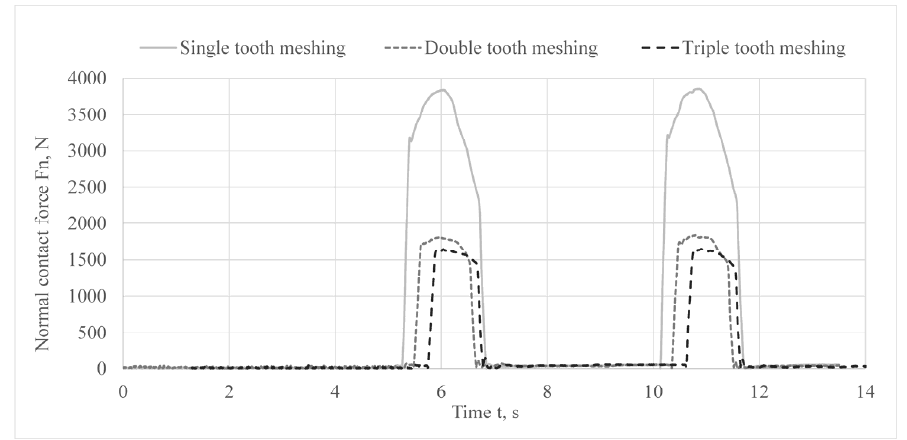
Figure 4. The input force achieved at the servo-hydraulic